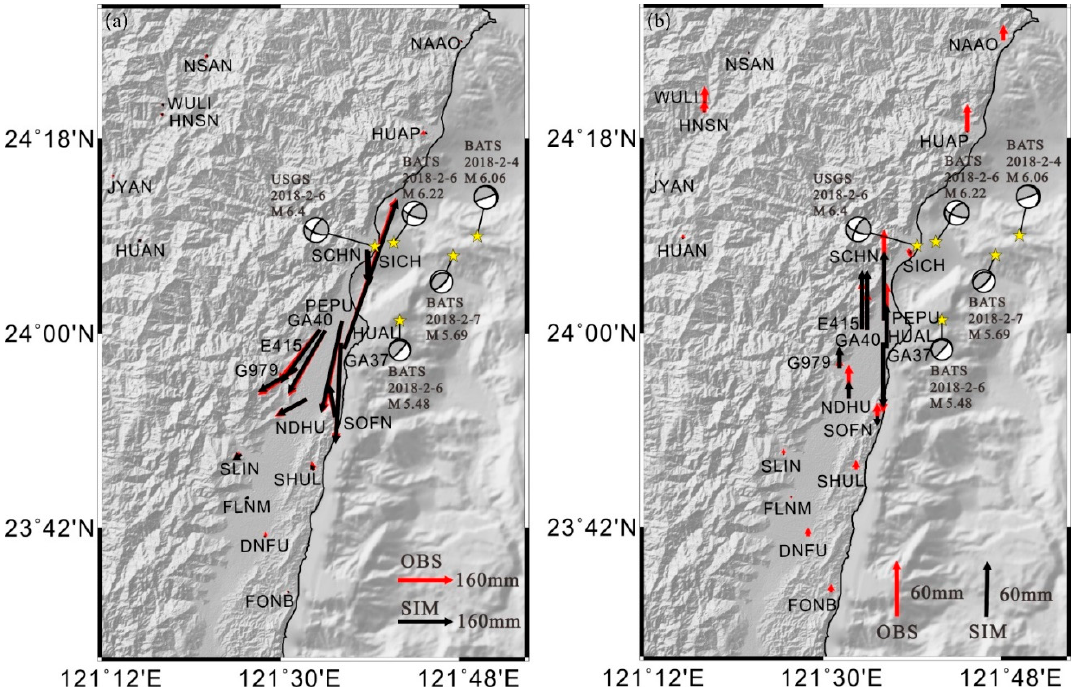
Figure 3. The co-seismic GPS displacements of the 2018 Hualien earthquakes. ( a ) The GPS horizontal surface displacements in the seismic zone of the 2018 Hualien event. The red vectors are the observed GPS displacements, the black vectors are the predicted GPS displacements based on the co-seismic faulting model shown in Figure 4a, and the beach balls are the focal mechanisms of the main shocks and major aftershocks of the 2018 Hualien events solved by USGS and BATS. ( b ) The observed (red vectors) and predicted (black vectors) GPS vertical displacements.